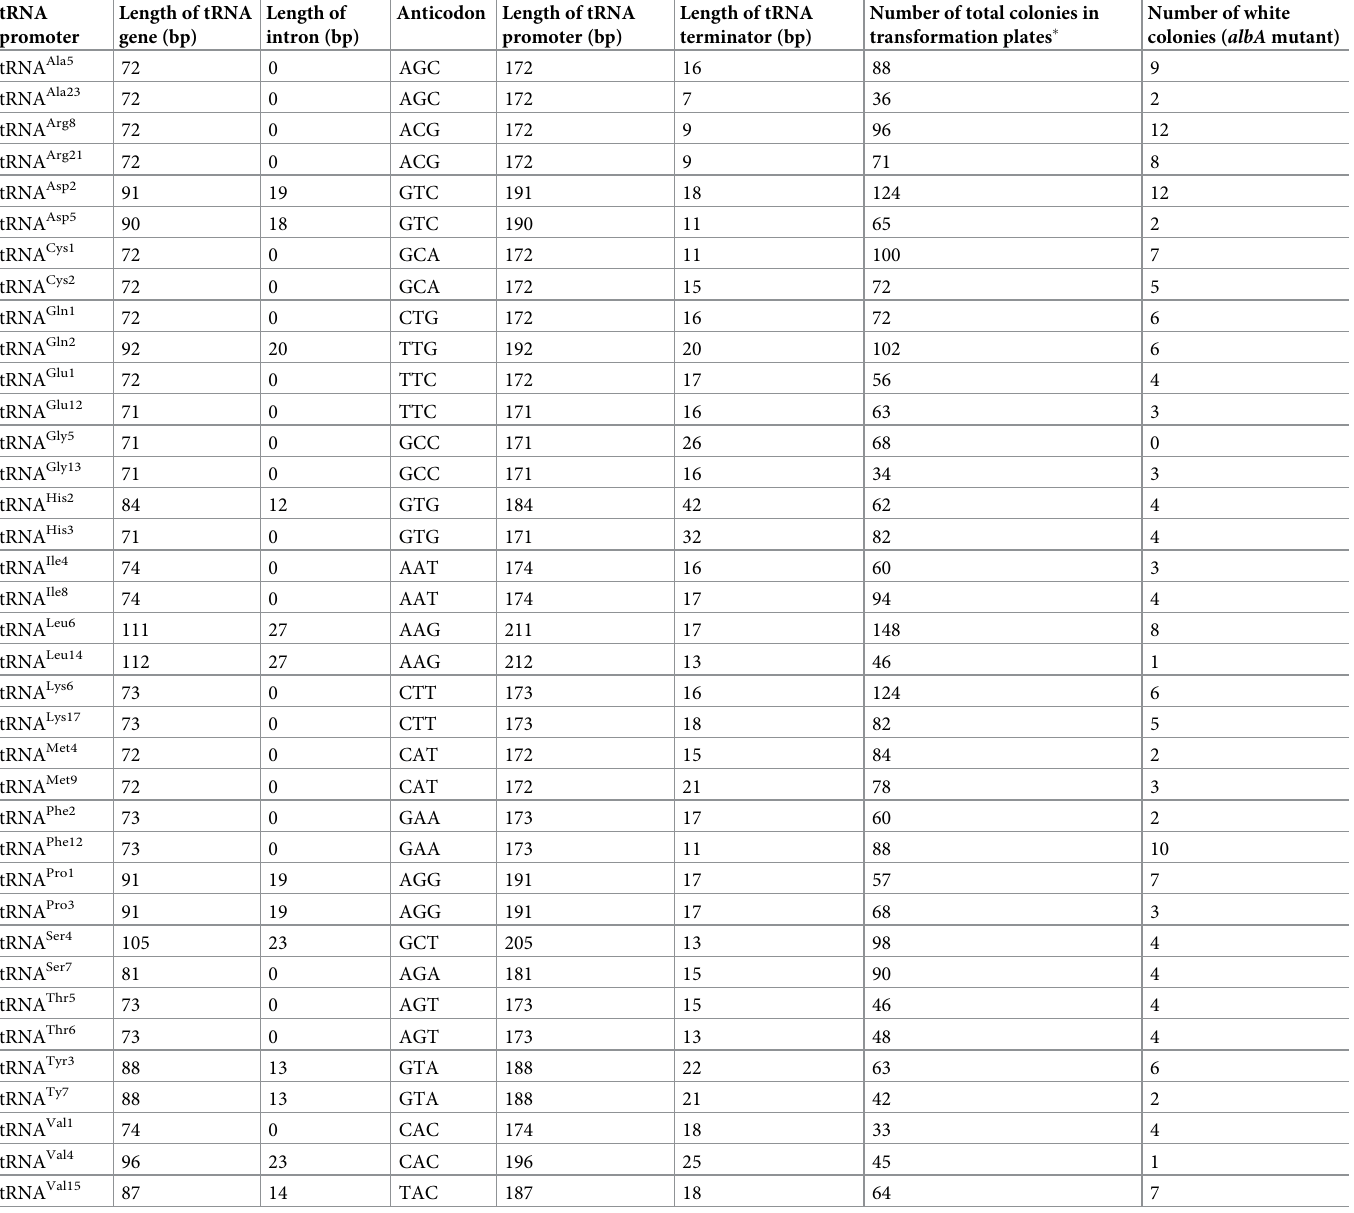
Table 1. Functional testing of 37 tRNA promoters and terminators in CRISPR/cas9 genome editing. tRNA Length of tRNA promoter gene